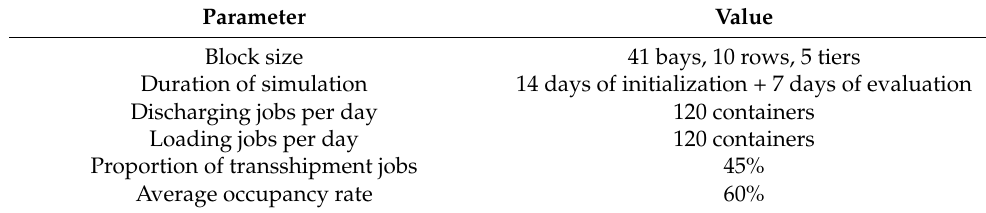
Table 2. Setting for simulation